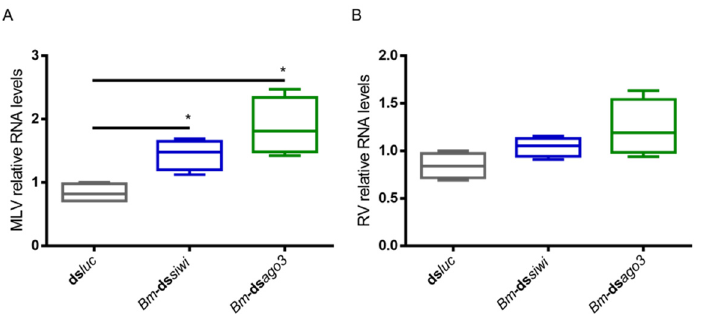
Figure 1. Relative RNA levels of B. mori Macula-like Latent Virus (MLV) and S. frugiperda Rhabdovirus (RV) in BmN4 cells upon Siwi and Ago3 knockdown. BmN4 cells were transfected with Bm -ds siwi , Bm -ds ago3 or ds luc (negative control). The graphs depict MLV ( A ) and RV ( B ) relative RNA levels, measured by qRT-PCR on day 3 post-transfection. Each box depicts the interquartile range, with the inner line representing the median. The whiskers represent the minimum and maximum values. Statistical analysis (Mann–Whitney test) was performed in GraphPad Prism 6 (* p < 0.05; n =